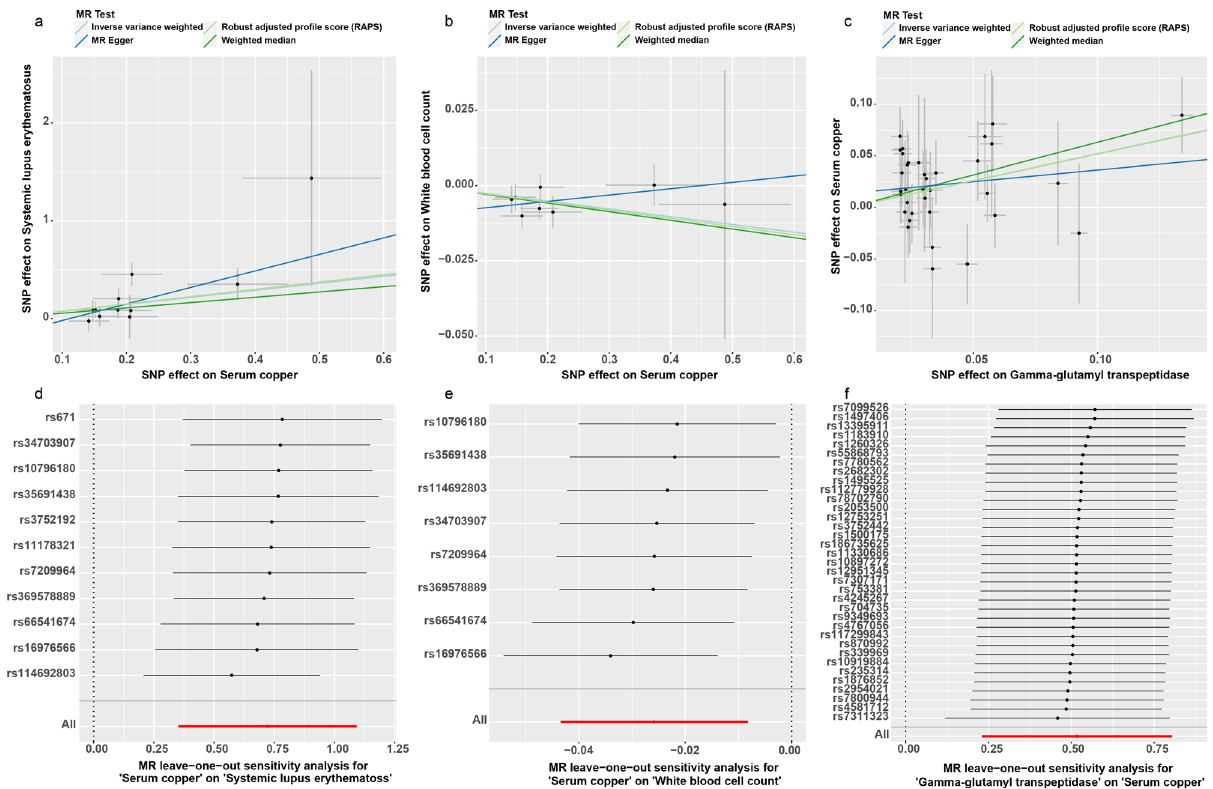
Fig. 4 Scatter and leave-one-out analyses plots for two robust results in the fi rst round two-sample Mendelian randomization analyses and one robust result in the second round two-sample Mendelian randomization analyses. The error bars in panels a – c indicate standard error. The error bars in panels d – f indicate the 95% con fi dence interval. a , d Systemic lupus erythematosus. b , e White blood cell count. c , f Gamma-glutamyl transpeptidase levels are exposure factors, and serum copper levels are the outcome. MR Mendelian